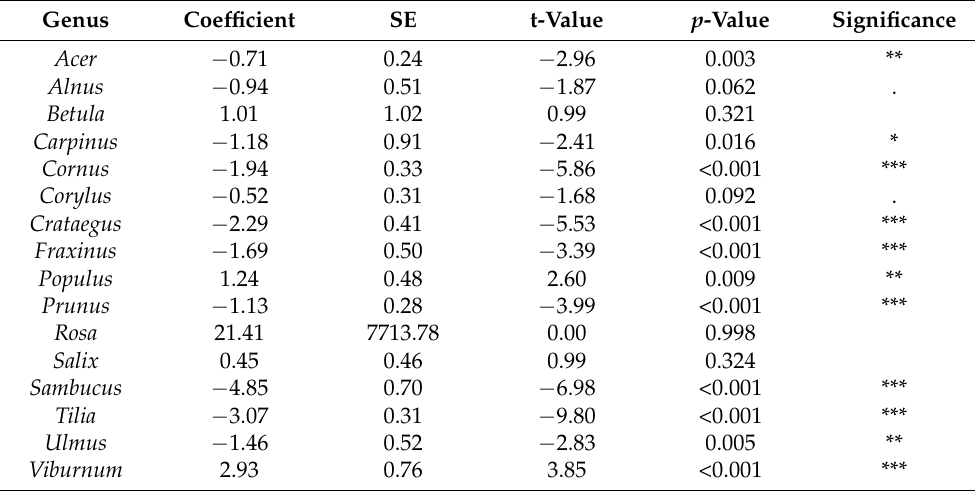
Table 2. Comparison of individual woody plant genera to Quercus , one of the most frequently felled and simultaneously commercial woody plants used as control. Negative t-values mean a less frequently felled wood species, and positive t-values a more frequently felled one. * p < 0.05,